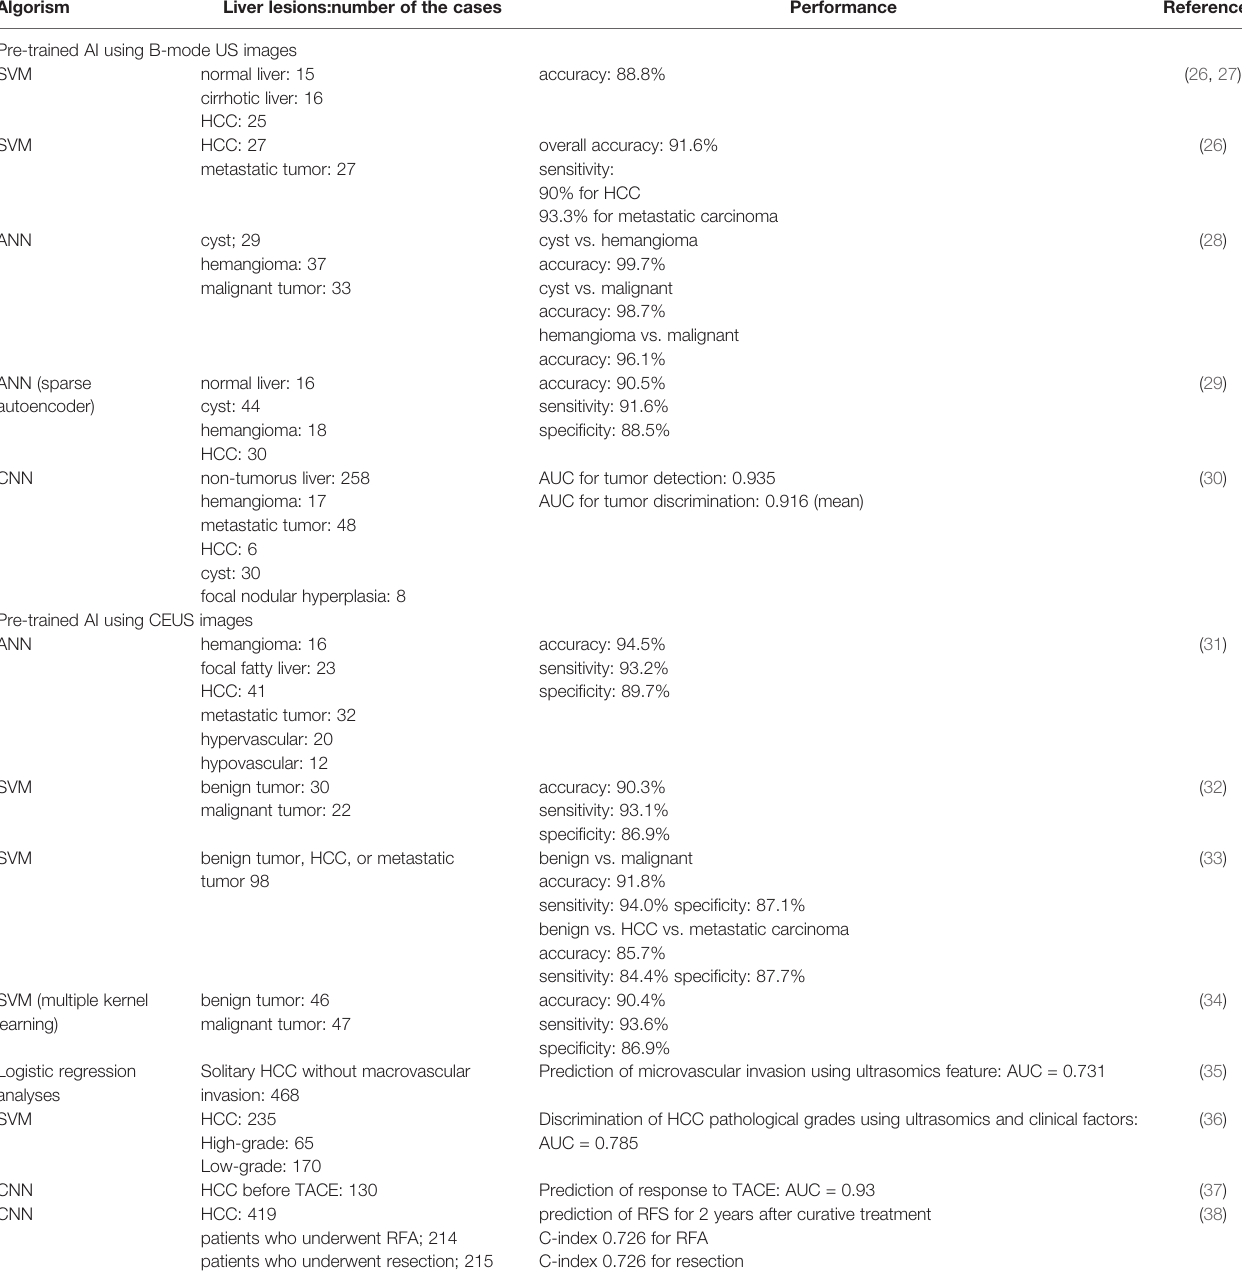
TABLE 1 | Performance for diagnosis of liver tumor based on the machine learning using image of ultrasonography. Algorism Liver lesions:number of the cases